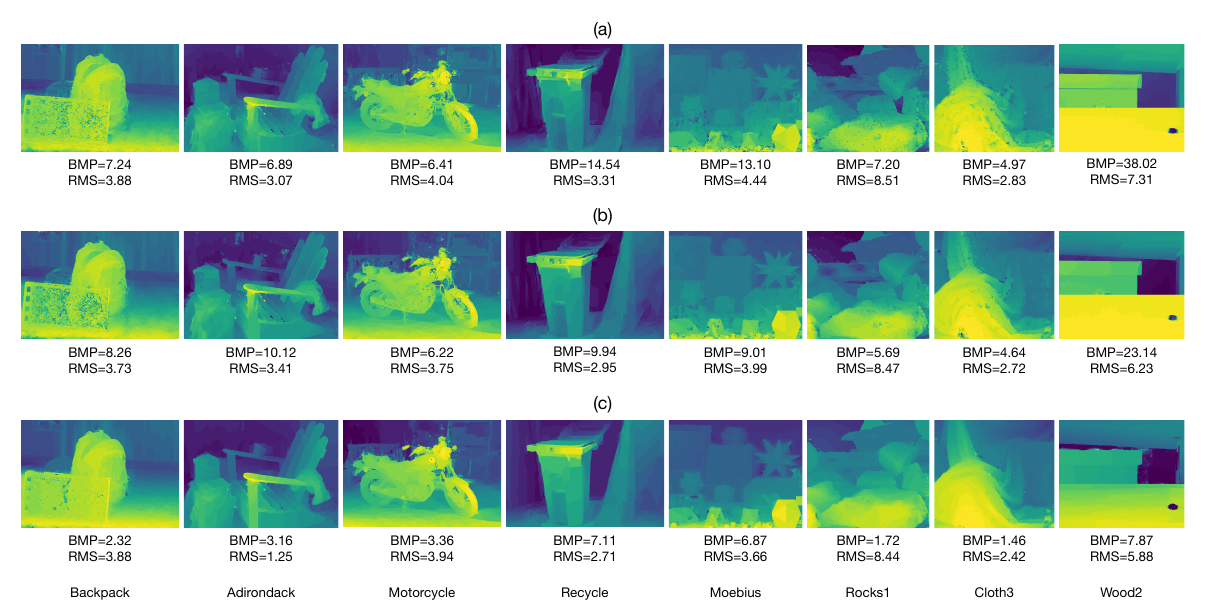
Figure 6. Refined disparity maps after applying the suggested post-processing method, obtained with: ( a ) IWCT, ( b ) AD-C and ( c ) Proposed method.